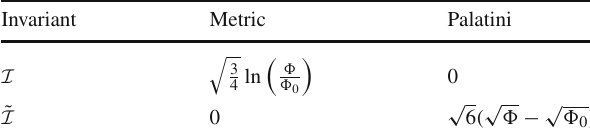
Table 2 Invariant scalar field for f ( R ) gravity in different approaches Invariant